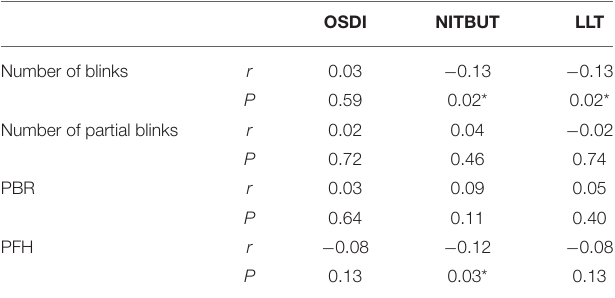
TABLE 2 | Correlation between blink parameters and ocular surface parameters (* P <